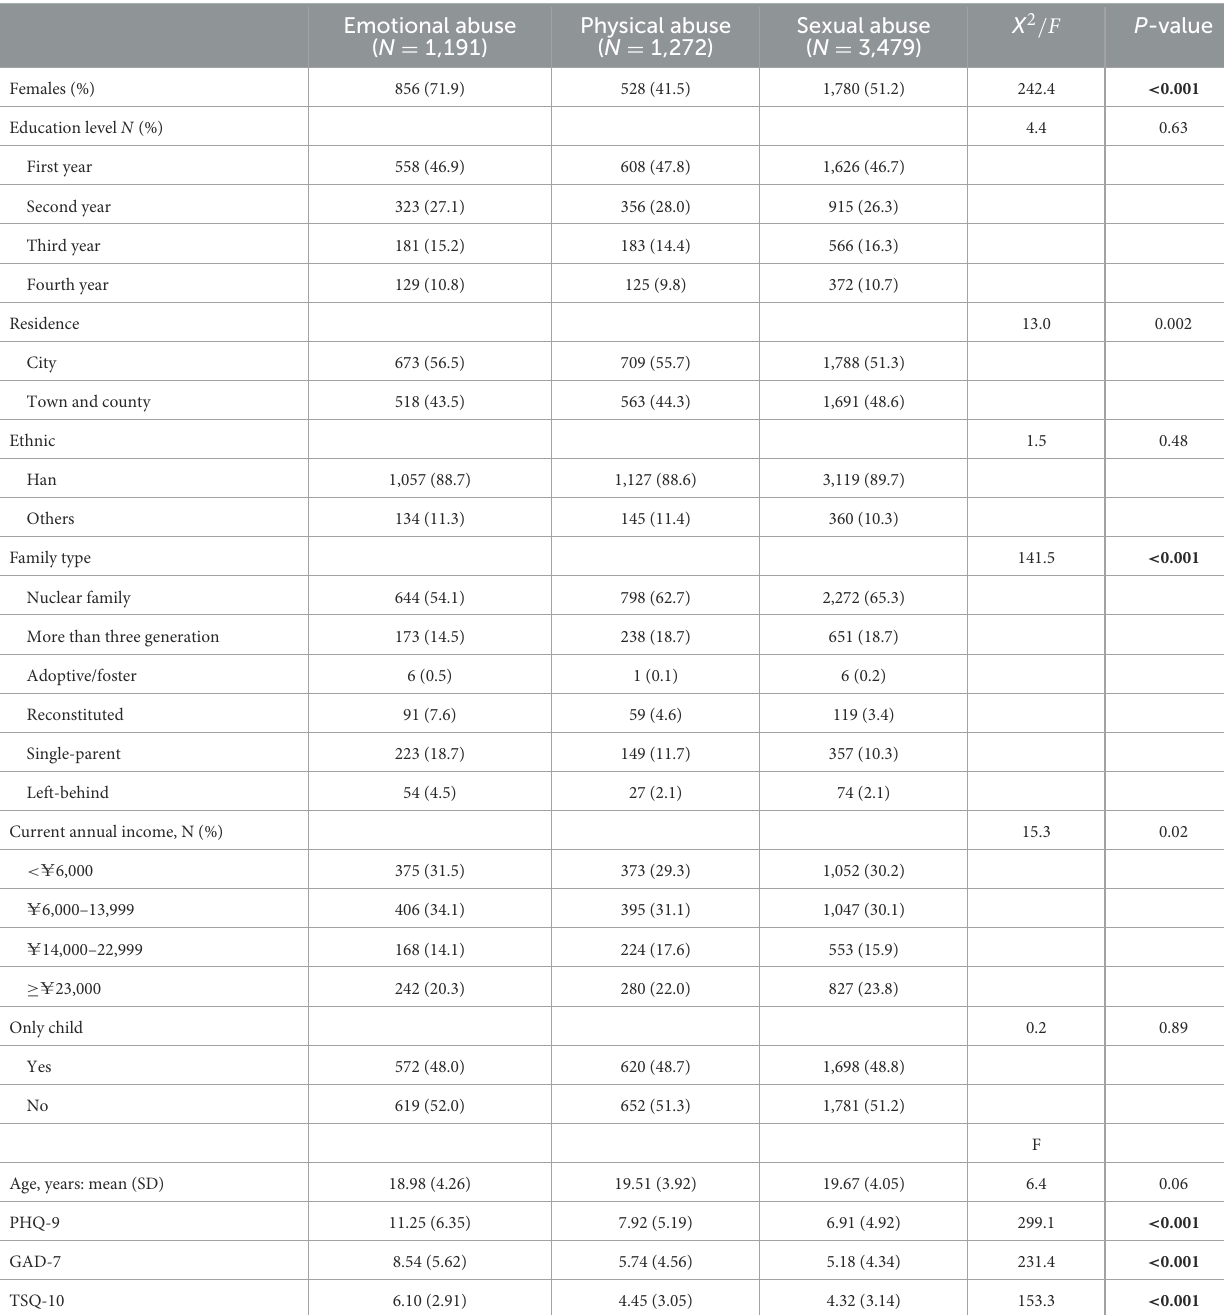
TABLE 1 Participants’ sociodemographic characteristics.